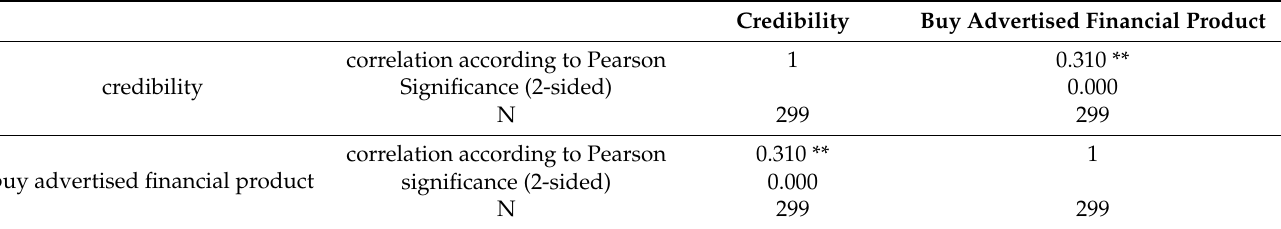
Table 5. Correlations